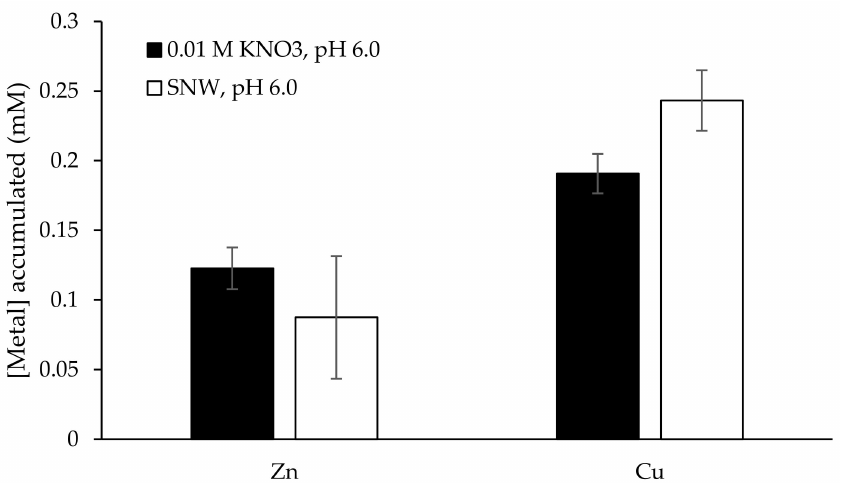
Figure 6. Effect of the matrix on metal accumulation. Feed phase: 100 mL of a 0.03 mM of Zn or Cu in 0.01 M KNO 3 , pH 6.0 or in SNW, pH 6.0; PIM: M2; receiving phase: 5 mL 0.01 M HNO 3 ( n =